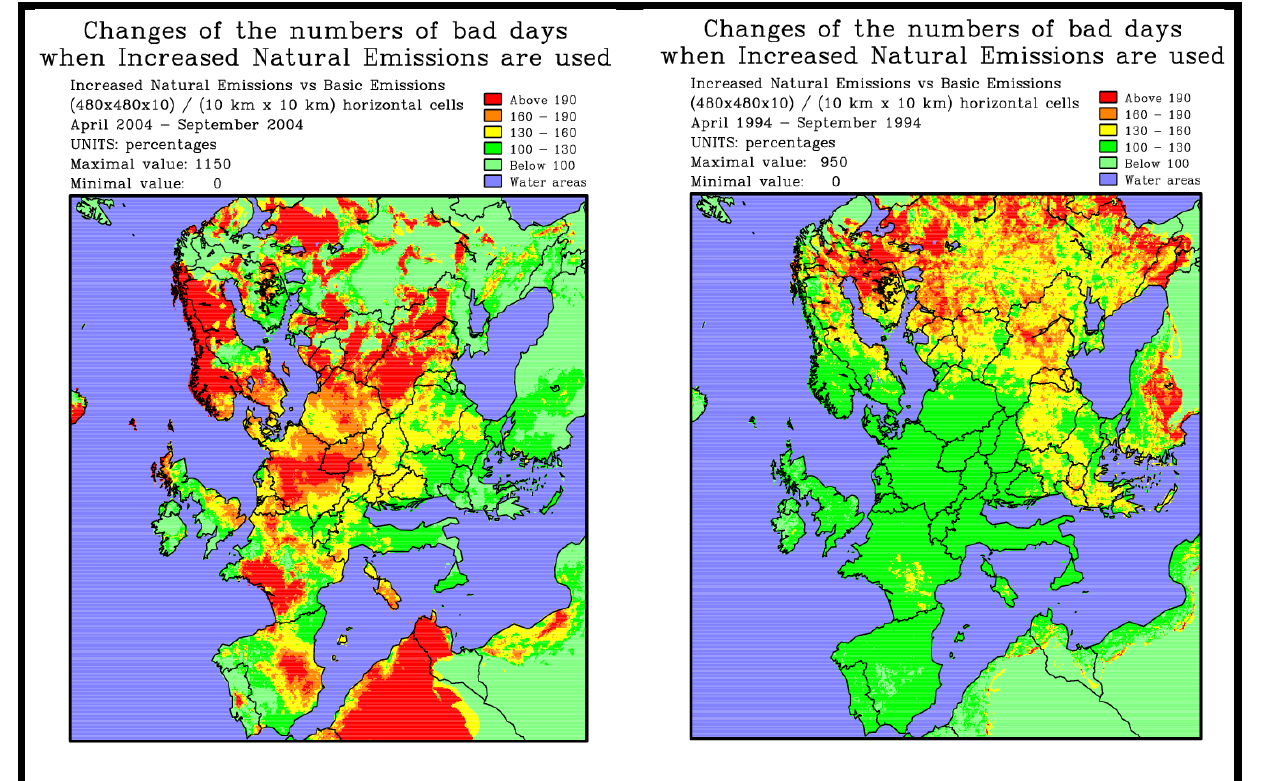
Figure 6. Increases (in percent) of the numbers of “bad days” in year 2004 (the left-hand-side plot) and in year 1994 (the right-hand-side plot) when the scenario with increased natural (biogenic) emissions is used. The numbers of “bad days” in these two years when the Basic Scenario is used are given in the left-hand-side plots of Figure 3.